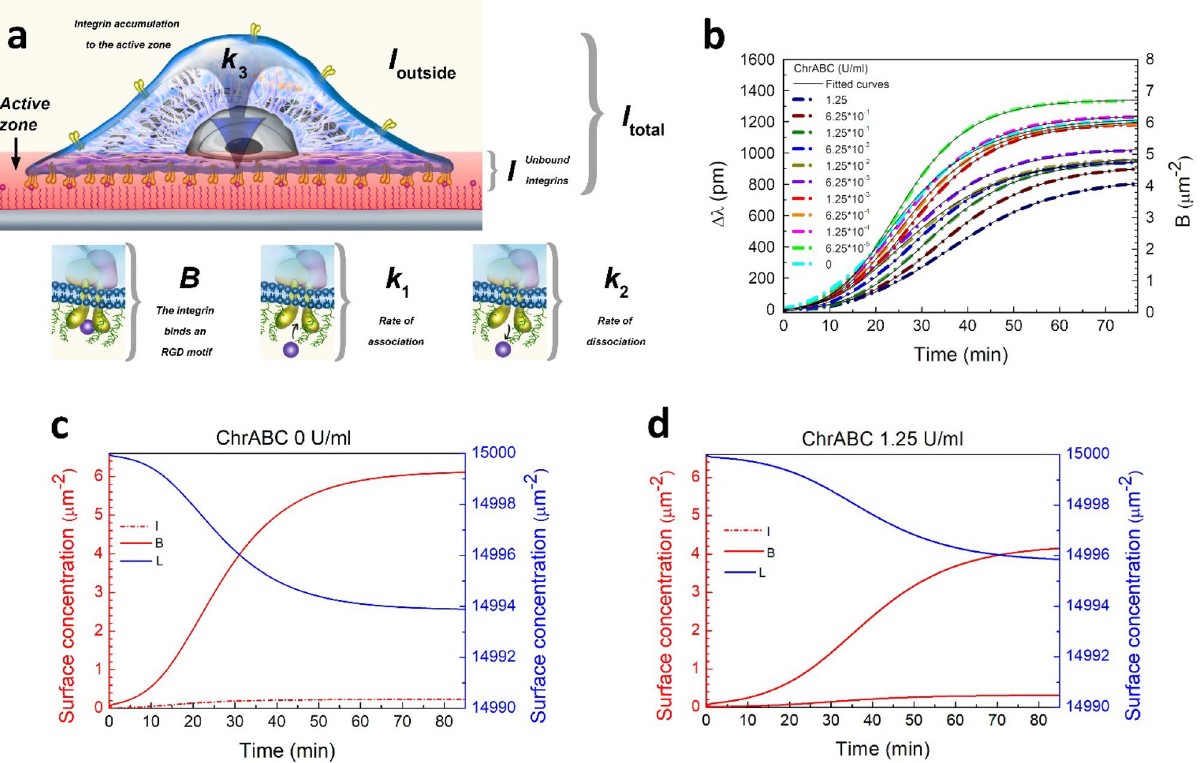
Figure 7. ( a ) Illustration of model parameters determining the adhesion kinetics. It represents the surface concentration of free integrins in the adhesion zone (monitored by the red shadow evanescent field). In the active zone, there are integrins which bind RGD motifs, with surface concentration B. The I and B together provide the surface concentration of all integrins inside the adhesion zone. Outside of the evanescent field (outside of the the adhesion zone), there are also integrins which did not accumulate to the active zone (‘ I outside ’). The total number of integrins (‘ I total ’) is the sum of the integrins in the active zone (‘ I ’ and ‘ B ’) and the integrins outside the zone (‘ I outside ’). k 1 represents the rate of integrin-RGD association, while k 2 the rate of dissociation, and k 3 the rate of the integrin accumulation to the active zone. ( b ) The measured experimental curves at 11 different ChrABC concentrations with the dotted line. The continuous lines represent results of kinetic modelling fitted to the data. ( c , d ) The fitted values of integrin (I), RGD (“Ligand”, L) and bound integrin ( b ) surface concentrations in time in case of 0 and 1.25 U/ml enzyme